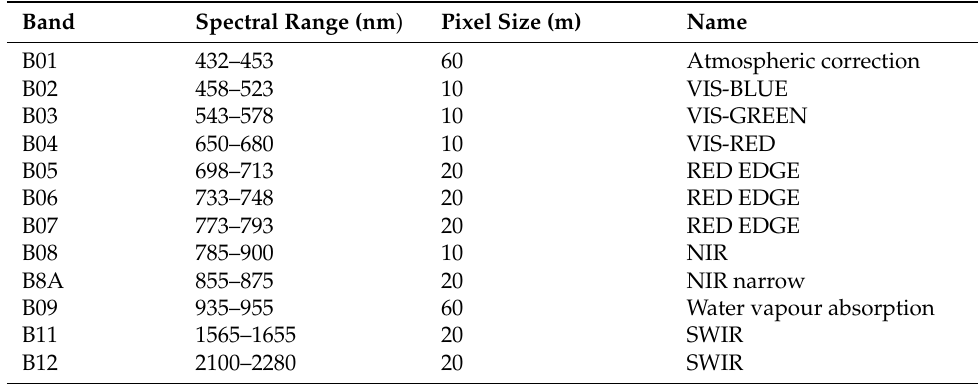
Table 1. Sentinel-2 band